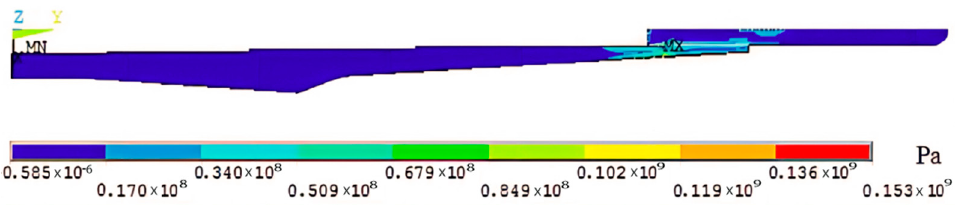
Figure 4. Thermal stress distribution diagram.